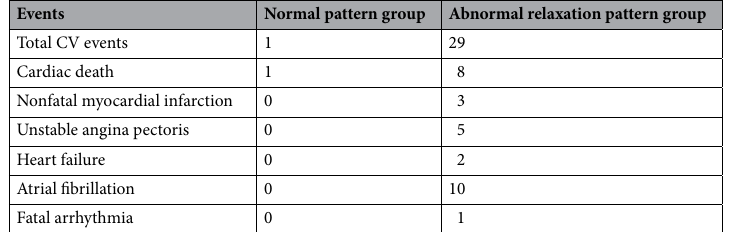
Table 4. Cardiovascular events among patients during the follow-up period. CV, cardiovascular.